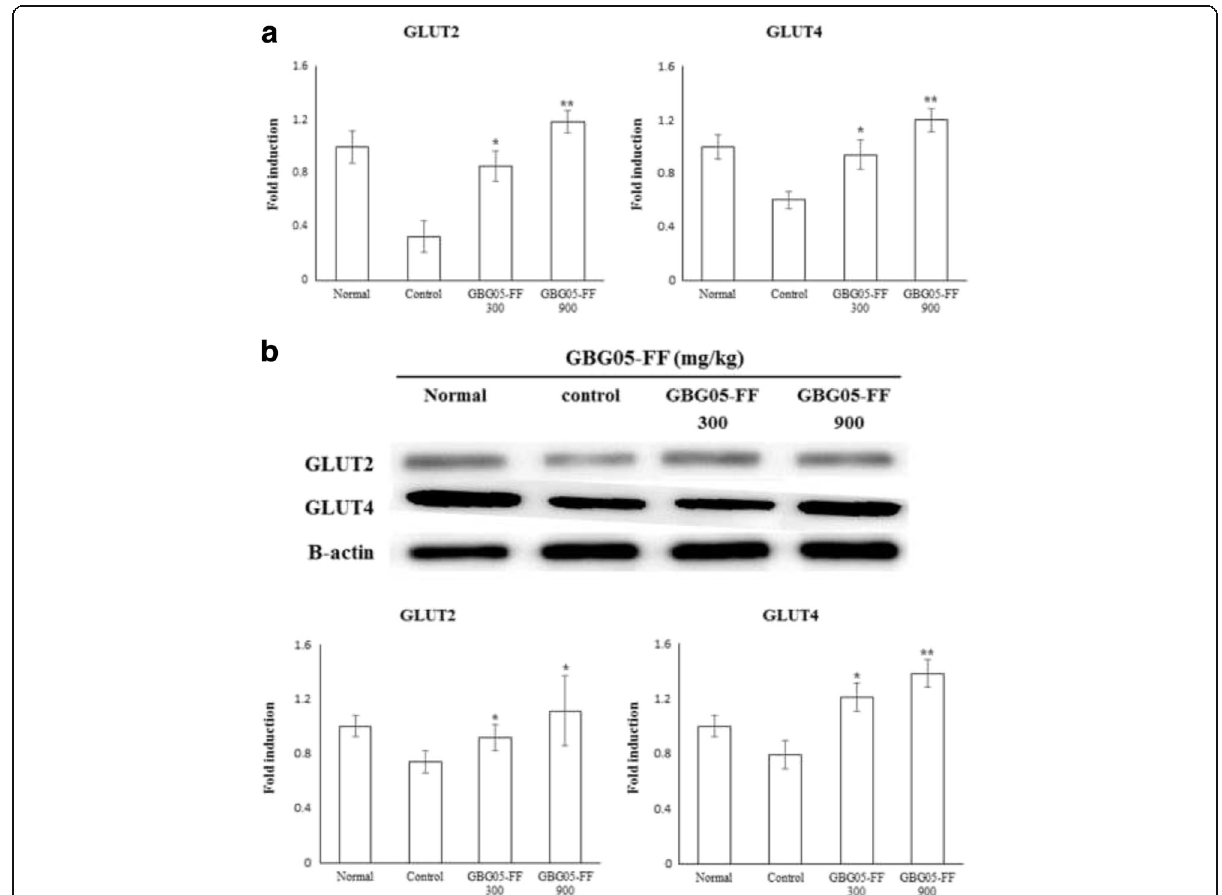
Fig. 5 Effects of GBG05-FF on the gene expression and the protein expression of GLUT2 in liver ( a ), and the gene expression and protein expression of GLUT4 in muscle ( b ) of mice. Normal: dbh, Control: db/db, GBG05-FF 300: db/db fed the GBG05-FF 300 mg/kg, and GBG05-FF 900: db/db fed the GBG05-FF 900 mg/kg. Each value represents the mean ± SEM ( n = 10 per group) in three independent experiments. * P < 0.05, ** P < 0.01: Significant difference vs. control